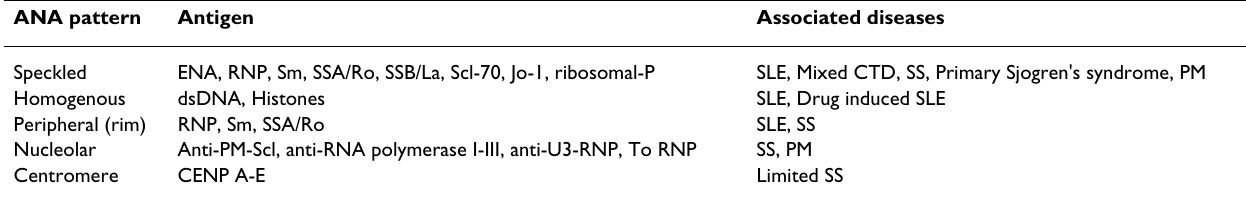
Table 3: Common IF-ANA patterns associated with specific diseases ANA pattern Antigen